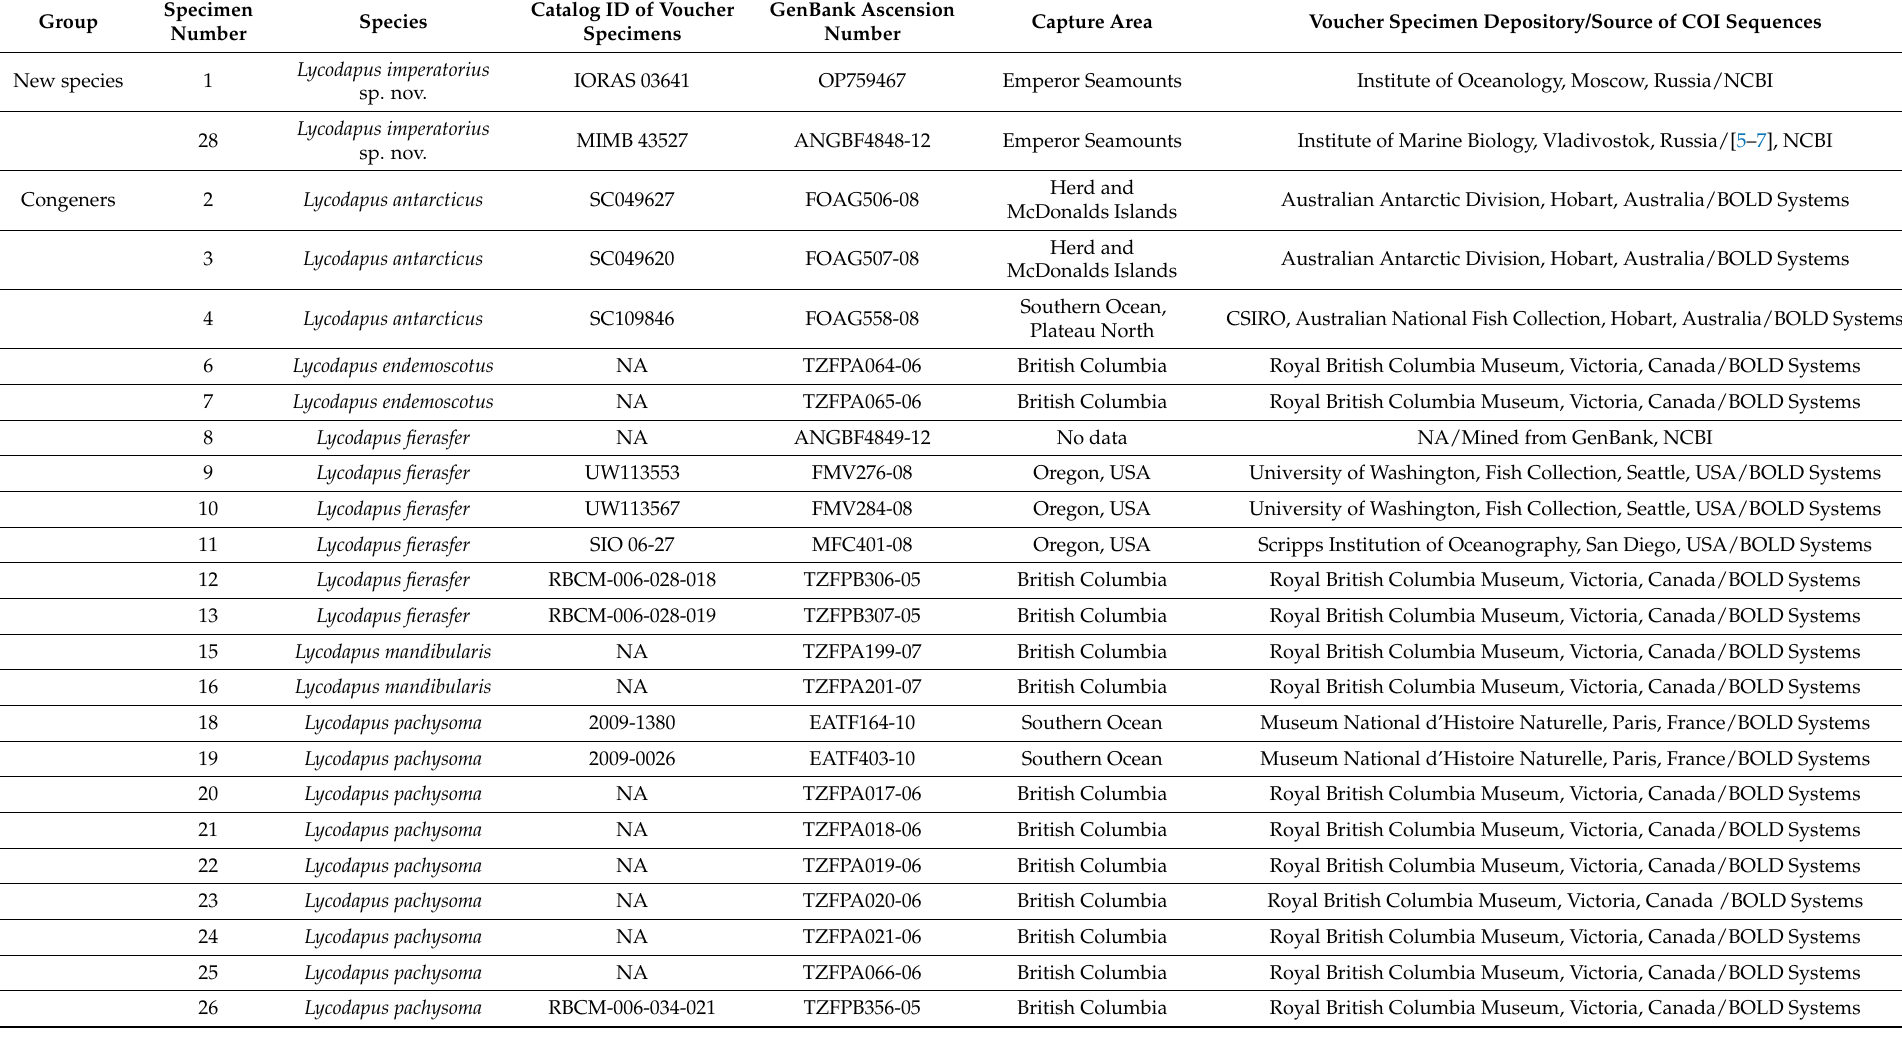
Table 1. Information about COI sequences and respective samples used for molecular analysis (NA—not available).